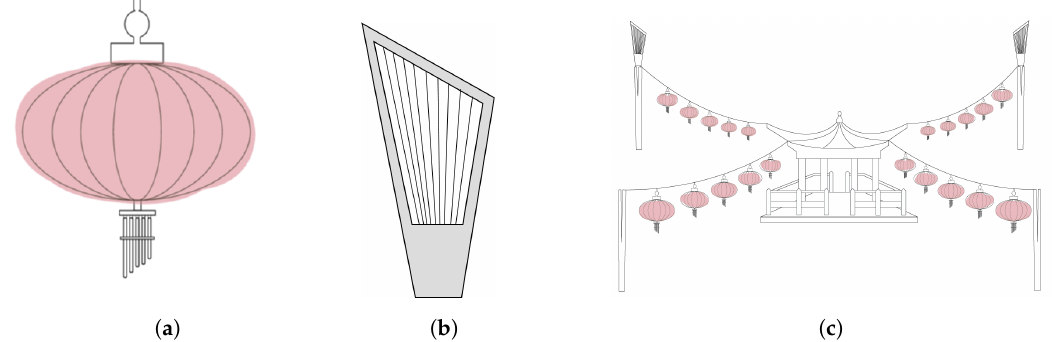
Figure 6. Adaptations to Signal Hill Garden by team URCHI. ( a ) Typical Chinese lantern modified with wind chimes. ( b ) Sketch of a wind harp. ( c ) Sketch of the adapted